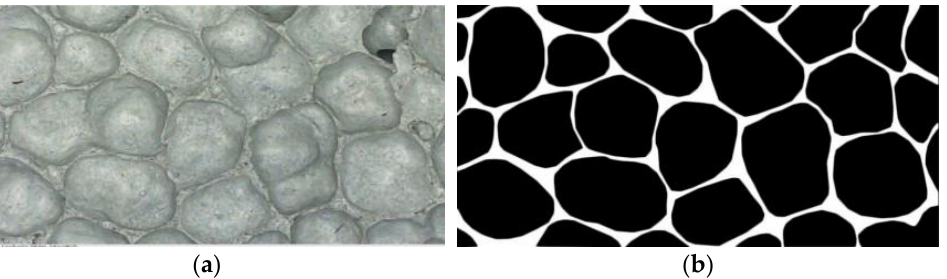
Figure 15. Pore cross-sectional image of silica fume dosing 4%: ( a ) original image, ( b ) cross-sectional image.